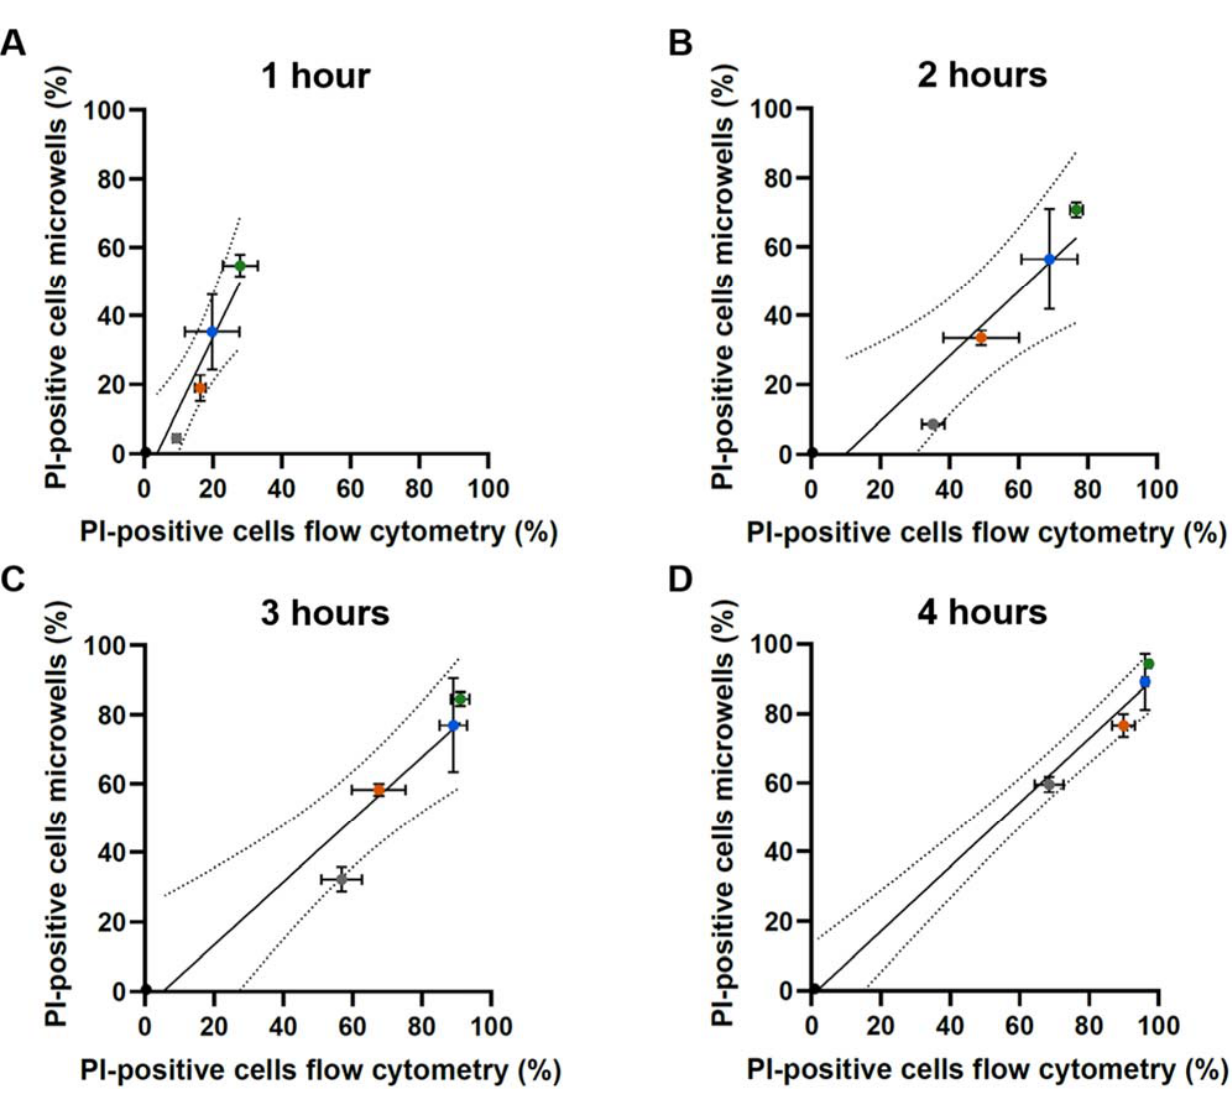
Figure 2. Pearson correlation analysis between the percentages of single yeast cells with compromised membranes obtained by flow cytometry (x ‐ axis) and by the continuous microfluidic setup (y ‐ axis). Yeast cells were treated with 0 (black), 50 (gray), 100 (orange), 200 (blue) and 300 (green) μ g/mL HsAFP1 during 1 h ( A ), 2 h ( B ), 3 h ( C ) and 4 h ( D ) at room temperature using PI that allows to evaluate membrane permeabilization. Note that image analysis on ‐ chip can only start from 1 h treatment of cells with HsAFP1 onwards. Means, standard deviations (SD) of three independent biological experiments (n = 3) and 95% confidence intervals of the Pearson correlation (dashed lines) are plotted, and Pearson r coefficients and p ‐ values are indicated.